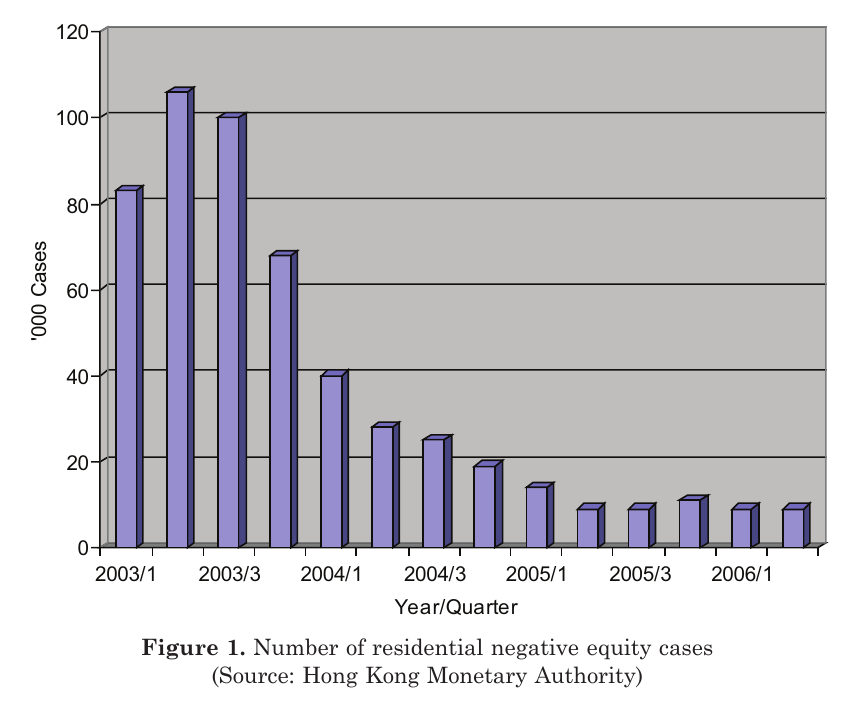
figure 1. Number of residential negative equity cases (Source: Hong Kong Monetary Authority)